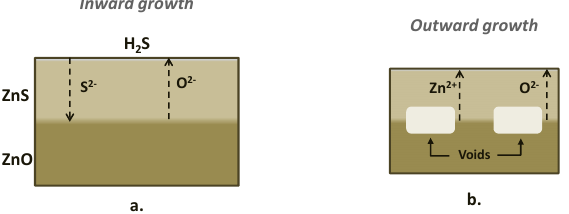
Figure 5. ( a ) Inward ZnS mechanism and ( b ) outward ZnS mechanism (adopted from [105]).